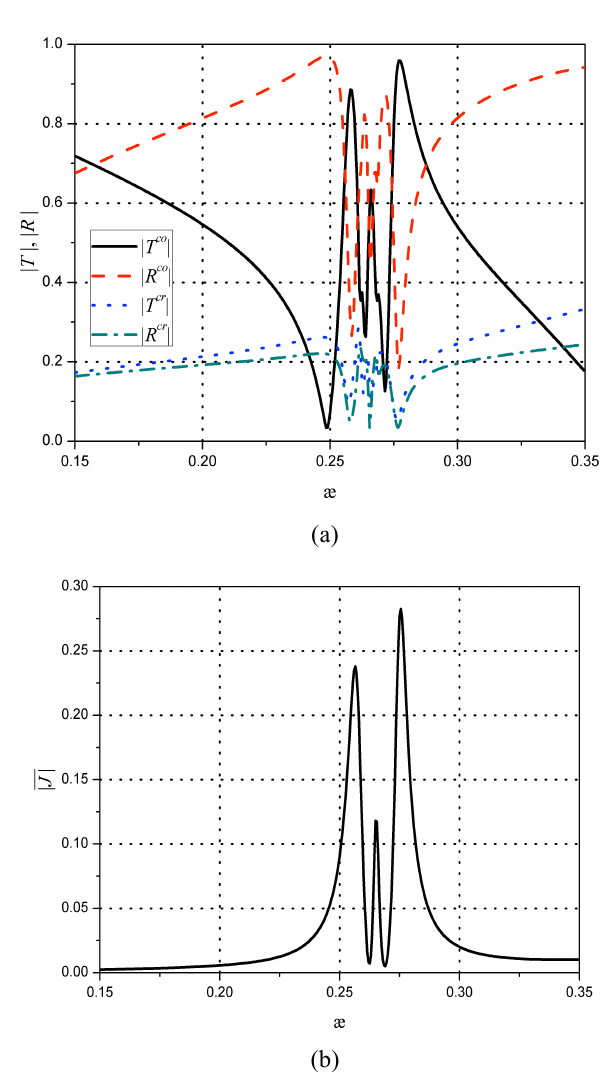
Figure 9. Reflection, transmission spectra (a) and average current magnitude (b) of the array placed on an antiferromagnetic substrate, linear regime. Figure 10. Inner field intensity versus incident field